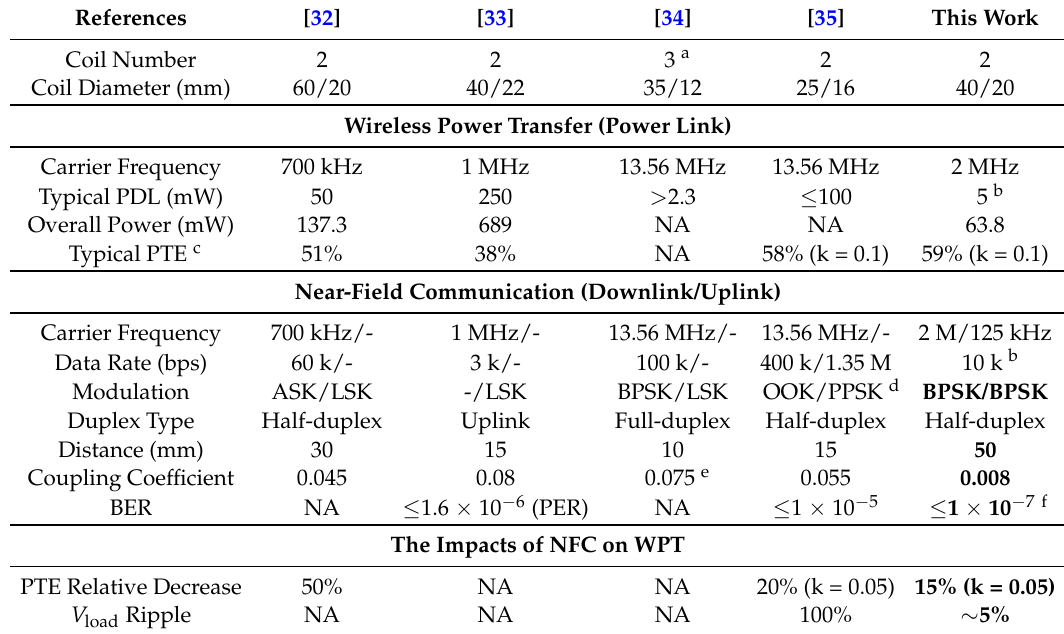
Table 2. Comparison with Other Single-inductive-link